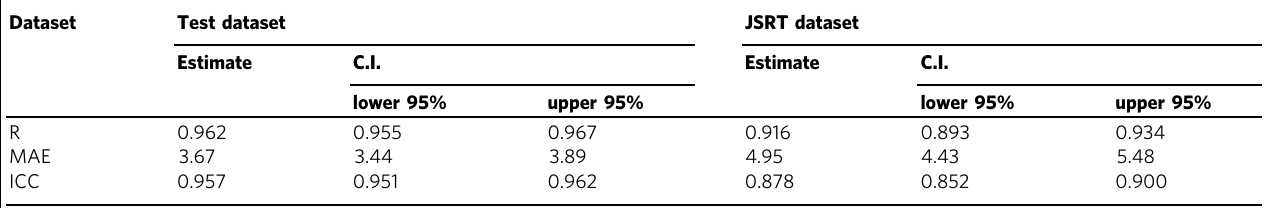
Table 1 Summary of estimation performance of DNN in the test and JSRT datasets. Dataset